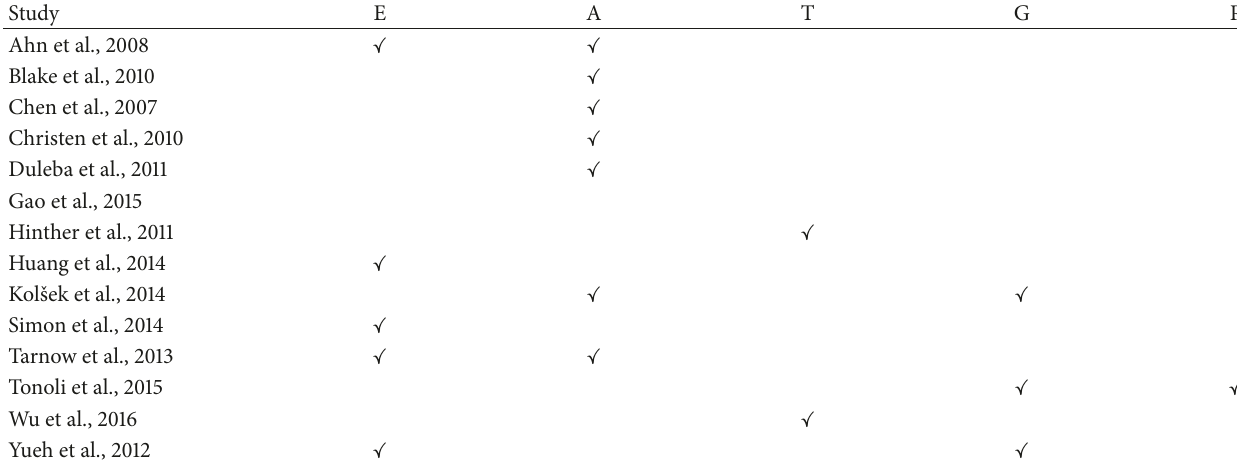
Table 5: Types of hormone systems assessed in vitro.